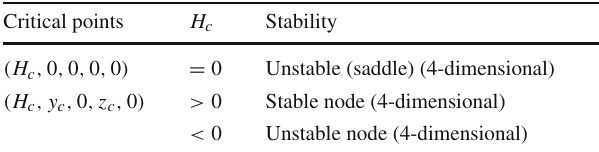
Table 4 Stability analysis (for v 0 =